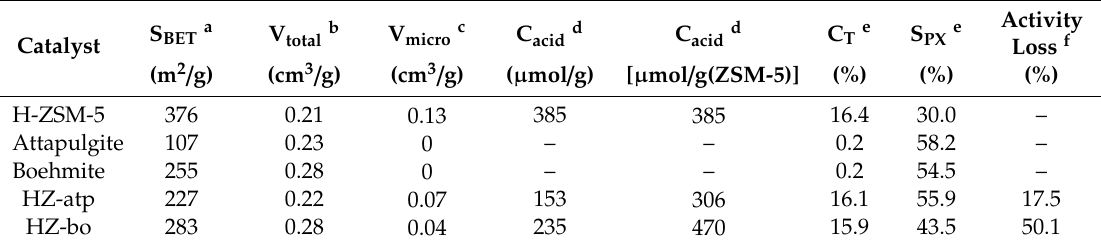
Figure 5. Nitrogen adsorption / desorption isotherms of powders ( a ) and extrudates ( b ). Table 1. Textural properties, acid sites concentration, and catalytic performance of the pure powder and extruded zeolite catalysts.